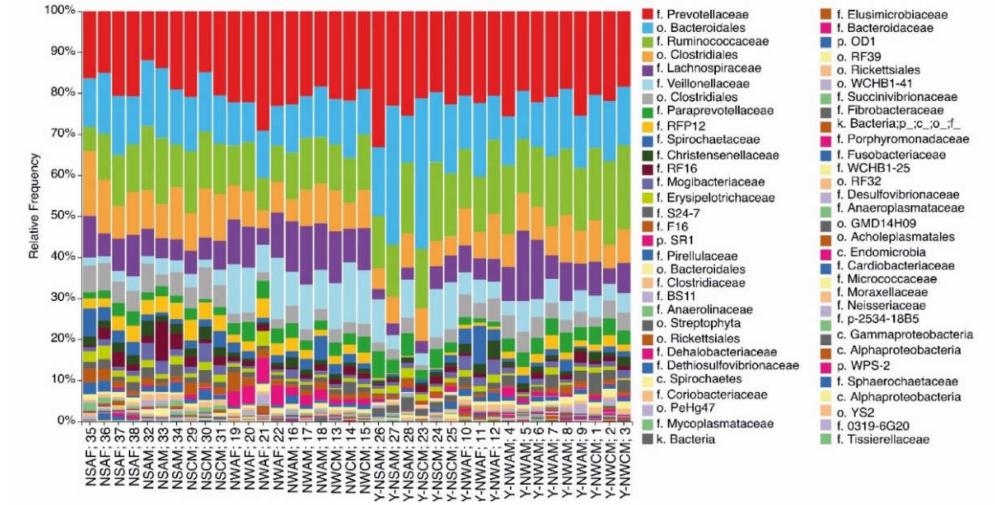
Figure 3. The taxonomic diversity (order level) of the ruminal microbial population in reindeer from Russian Arctic zones. Regions: N—Nenetski Autonomous District (AD); Y-N—Yamalo-NenetskiAD. Seasons: S—summer; W—winter. Age: A—adults; C—calves. Sex: M—male;